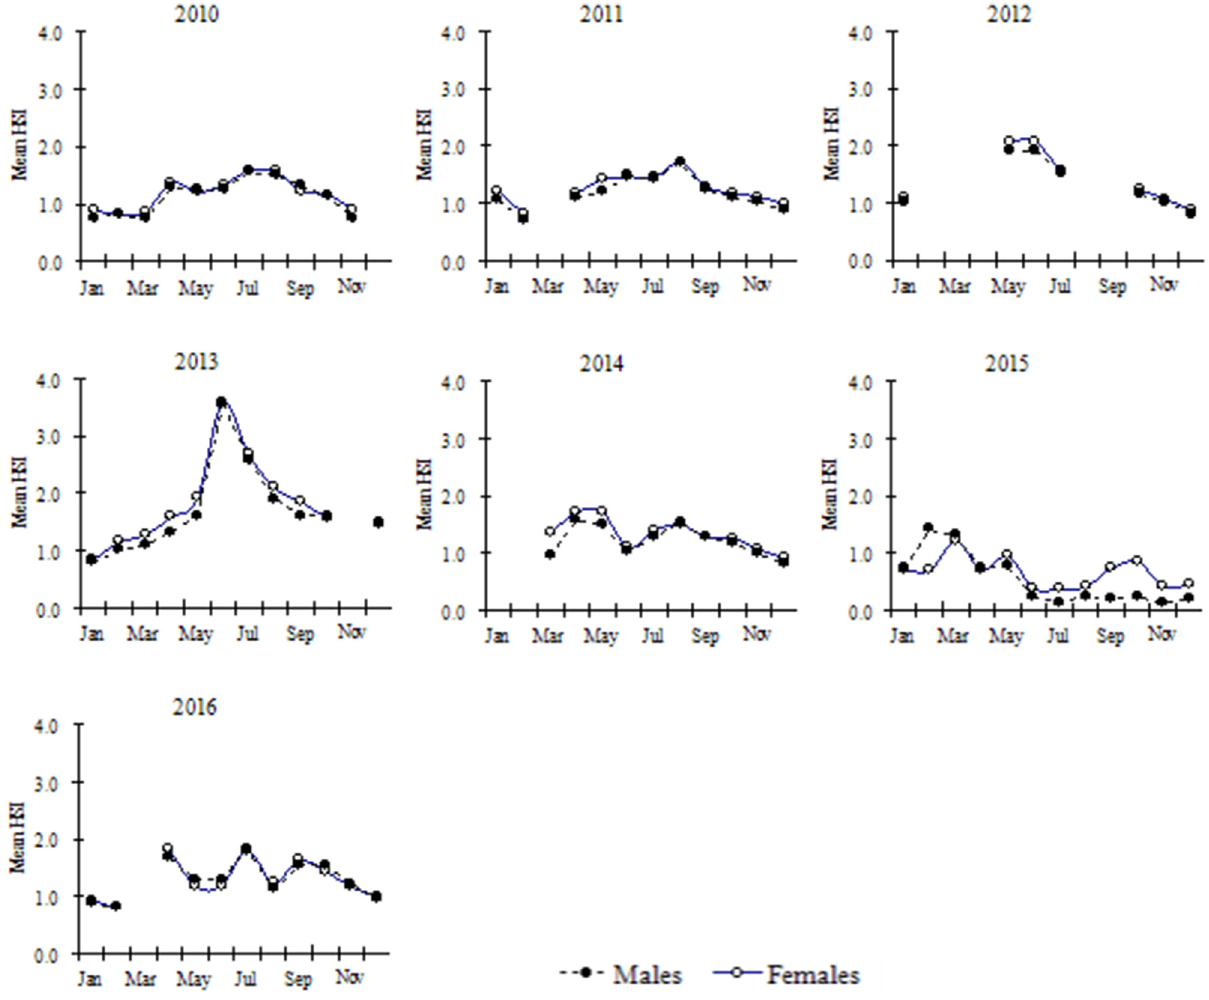
Fig. 7. Mean monthly hepatosomatic indices (HSI) (males and females) for T. picturatus from north-east Atlantic waters (Portuguese